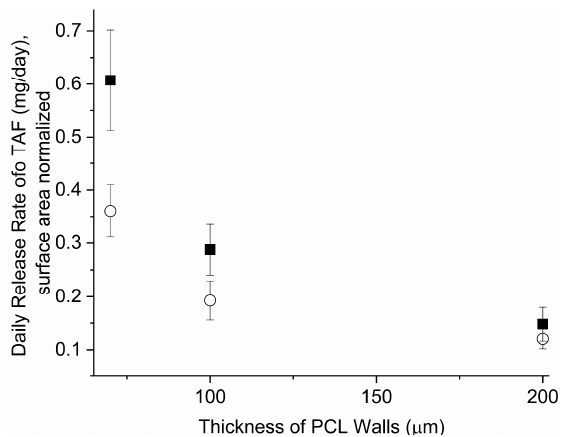
Figure 4. Effect of PCL type on daily release rates of TAF (mg/day) from implants with different wall thicknesses and fabricated with ( ■ ) Sigma -PCL or ( ○ ) PC-12. Implants contained a formulation of 2:1 TAF-castor Oil. Daily release rates were calculated from release over at 35 days and three implants were tested per condition.